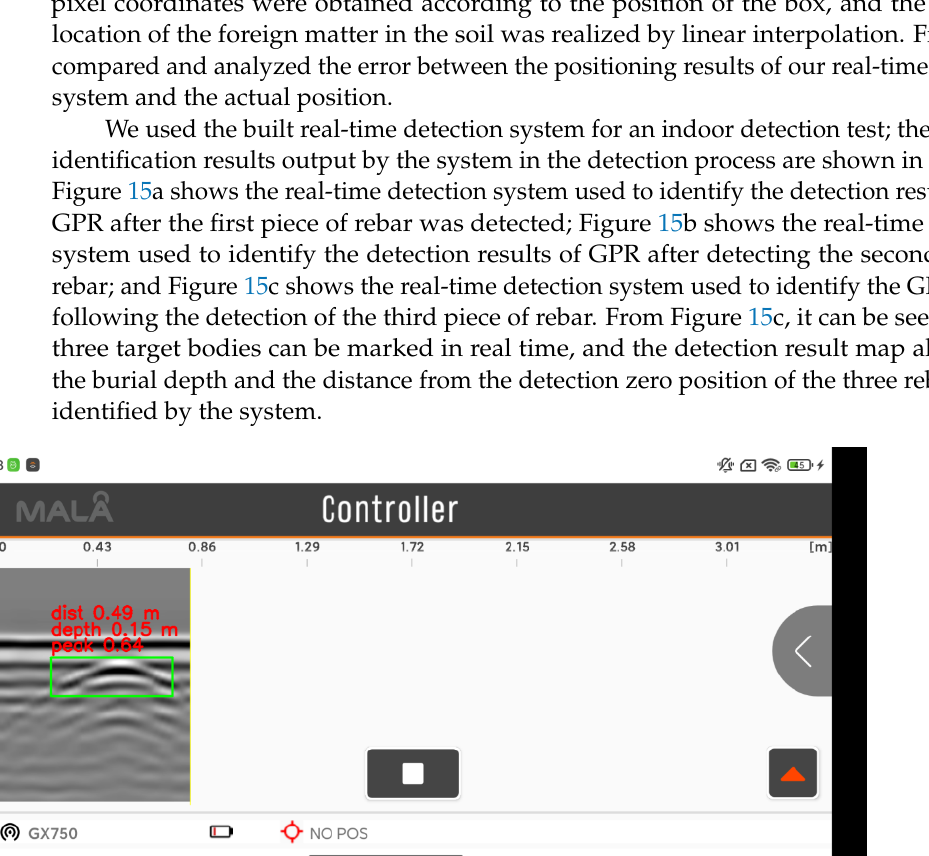
( a ) The result of the real-time detection system used to identify the ground-penetrating radar results after passing over the first steel bar. Figure 15. Cont